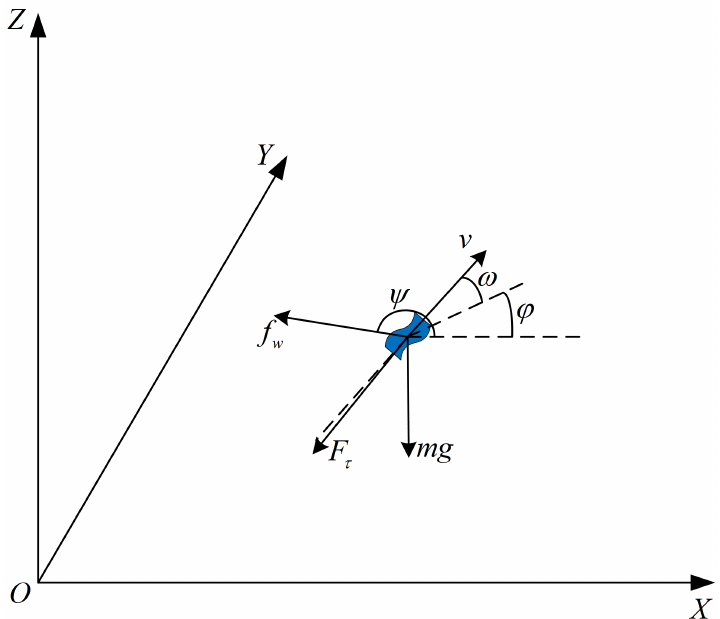
Figure 1. Schematic diagram of the force analysis of a jet